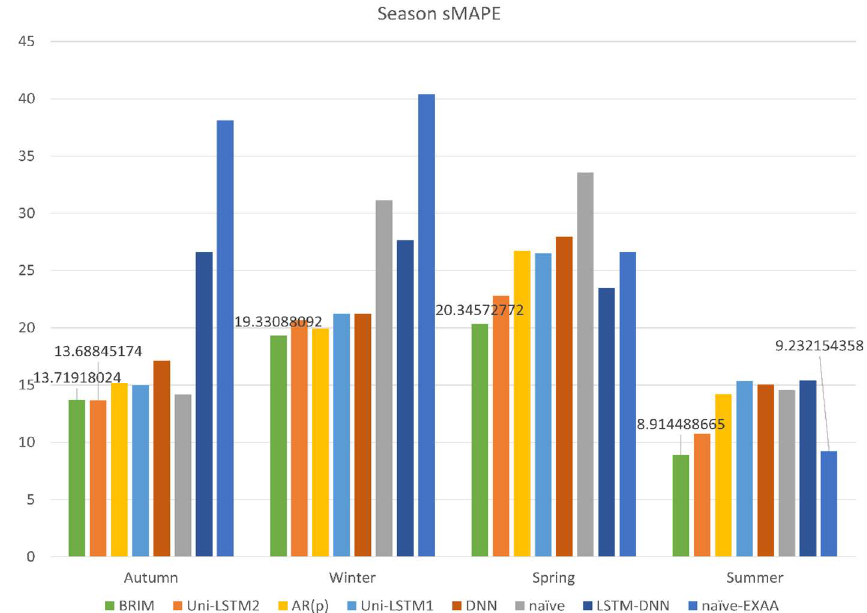
Figure 6. Comparison of predictive performance in four seasons by means of mean absolute error (MAE).